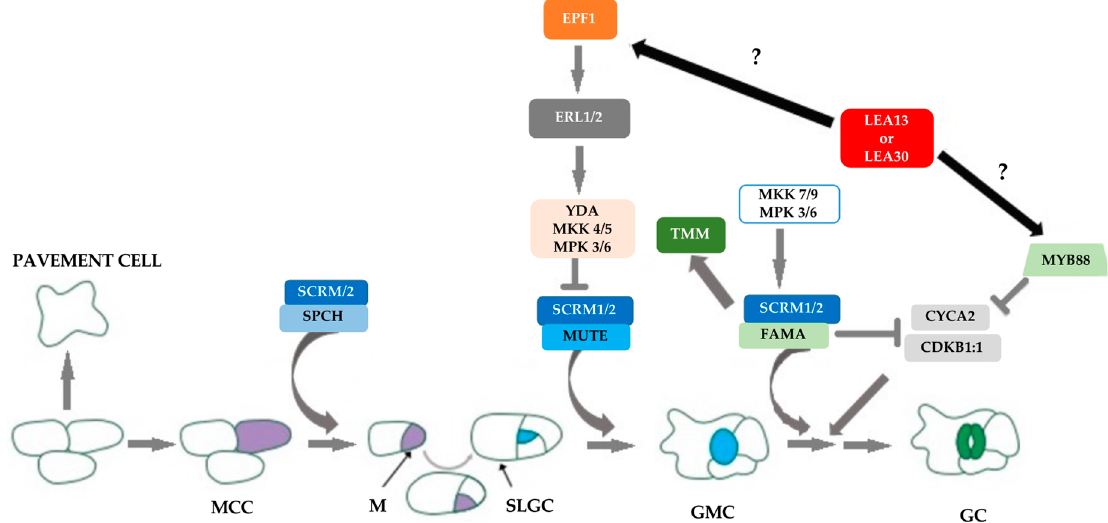
Figure 9. The hypothetical role of LEA proteins during stomatal development in Arabidopsis. A part of the protodermal cells acquires the character of meristemoid mother cells (MMCs); the MMC undergoes asymmetric cell division and gives rise to a meristemoid (M) and a stomatal lineage ground cell (SLGC). Meristemoids can undergo asymmetric amplifying divisions before differentiating into a guard mother cell (GMC). GMC undergoes symmetric division to form a pair of guard cells (GC), forming SCRM1 or SCRM2, playing essential roles in the respective key steps, as indicated by arrows. FLP1 and MYB88 are MYB transcription factors that regulate key fate transitions during stomatal development. LEA13 and LEA30 can both activate directly or indirectly on FLP1/MYB88 and some cyclins for modulation of cell divisions or EPF1, a peptide secreted from meristemoids and GMC cells, is perceived by a receptor complex consisting of ERL1, TMM, and SERKs, which prevents the meristemoid from producing stomata next to the existing stoma.